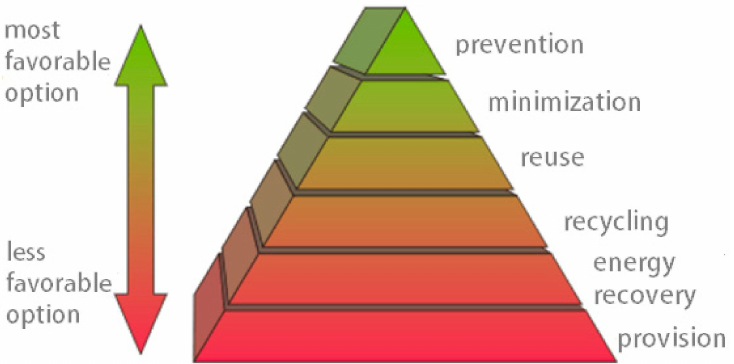
Figure 1. Waste hierarchy. Source: own